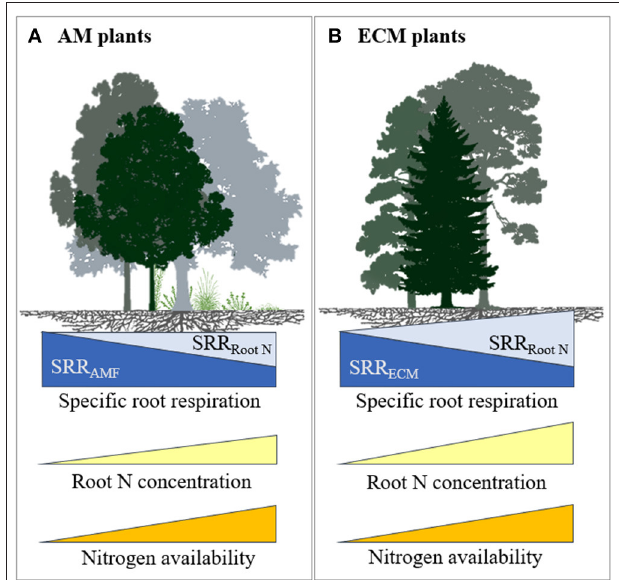
FIGURE 5 | Conceptual model illustrating the influence of soil N availability on SRR and root N concentration for plants in association with (A) AM and (B) ECM fungi. With increased soil N availability, both ECM and AM plants spend less C to support mycorrhiza resulting in reduced SRR associated with mycorrhizal symbiosis (a dark blue component of SRR) but respire more C due to an increase in root N concentration (a light blue component of SRR). However, the increase in plants C costs associated with higher root N concentration outweighs the reduction in C to support ECM fungi, while it counterbalances the reduction in C to support AM fungi. Furthermore, in AM plants, C costs for mycorrhizal symbiosis may remain relatively high at high soil N availability, because AM symbiosis is more important for P uptake. We refrained from drawing models for NM and AM + ECM plants due to limited